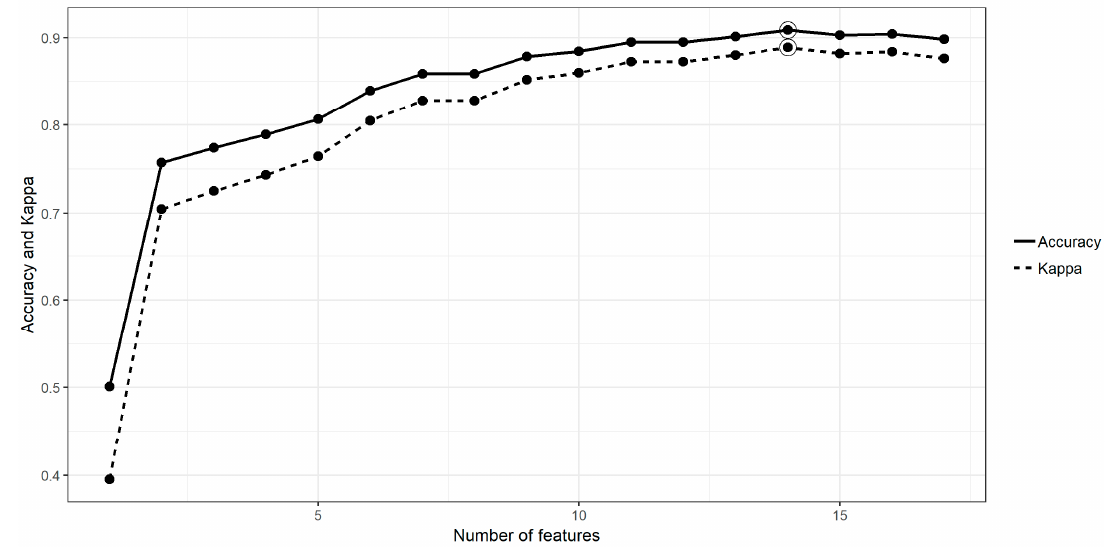
Figure 5. Overall accuracy and Kappa changing with number of features by recursive feature elimination (RFE) basing on the Random Forest (RF).